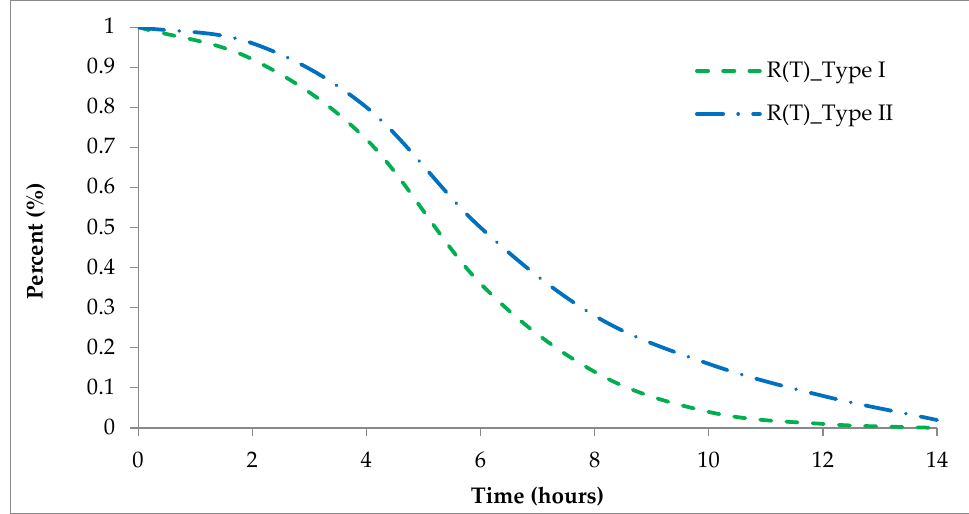
Figure 8. Comparative analysis of the reliability functions for the analyzed milling